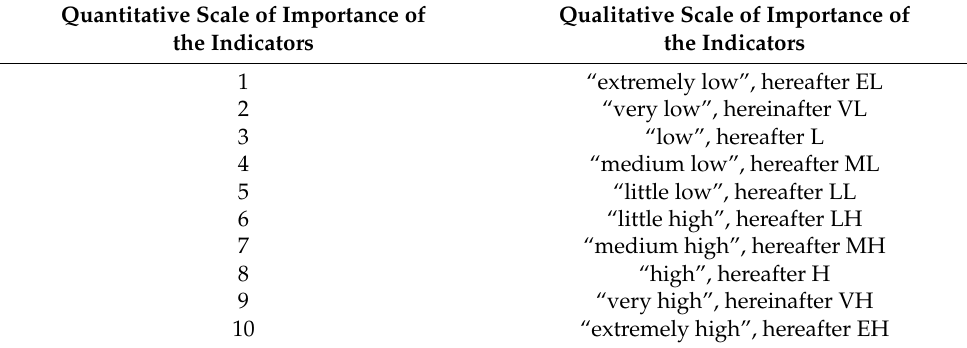
Table 2. Scale of importance of the experts when completing the form.